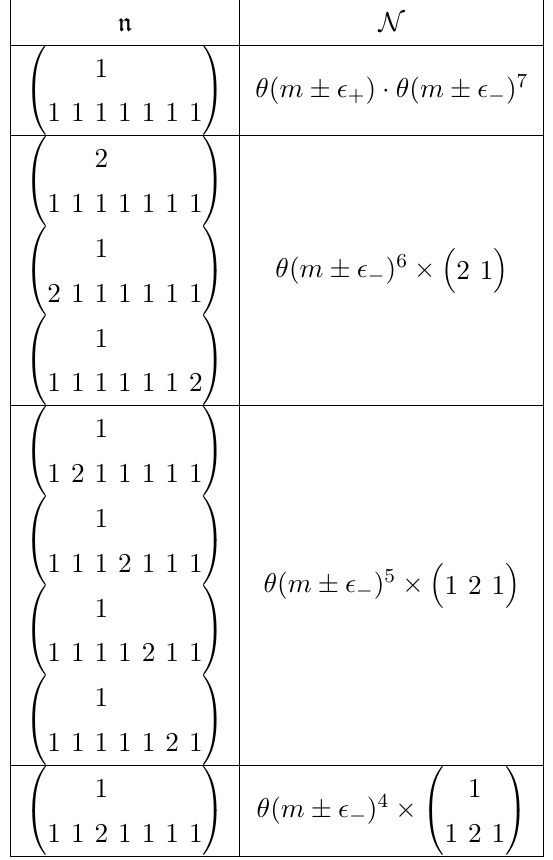
Table 8 . Elliptic genera of E 8